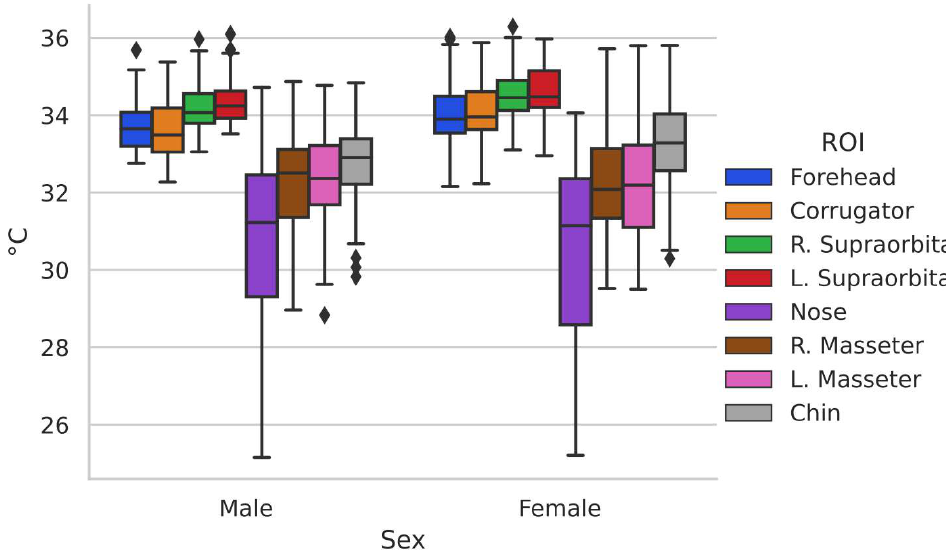
Figure 4. Box-and-whisker chart representing male and female gender.